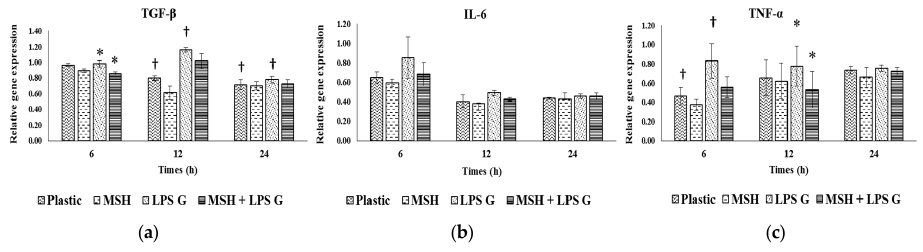
Figure 5. Gene expression of TGF ‐β ( a ); IL ‐ 6 ( b ); and TNF ‐α ( c ) in fibroblast cells. Relative mRNA levels were analyzed by real ‐ time RT ‐ PCR for IL ‐ 6, TGF ‐β and TNF ‐α in FB after 6, 12 and 24 h on cell culture ( n = 4). Data are expressed as mean ± SD. †: di ff erence between non ‐ stimulated and stimulated cells, p < 0.05; *: difference between stimulated cells with or without PGA ‐α‐ MSH, p < 0.05.